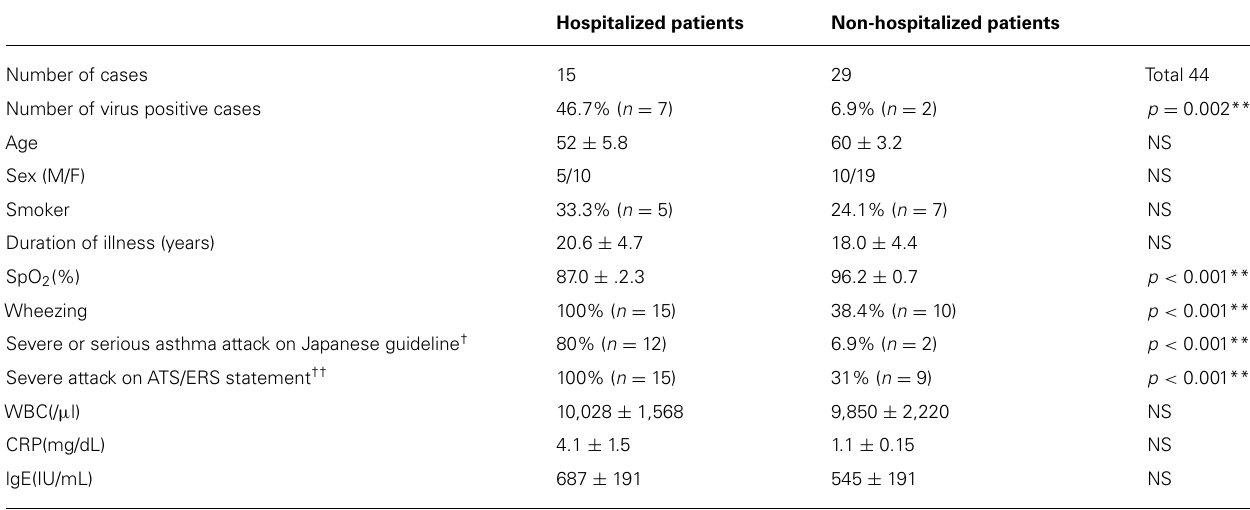
Table 3 | Comparison of the clinical characteristics of hospitalized and non-hospitalized asthma attack